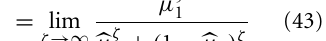
FIGURE 4 | The unit square sigmoid (cf. Equations 43, 44). The parameter ζ can be interpreted as inverse response noise because the sigmoid approaches a step function as ζ approaches